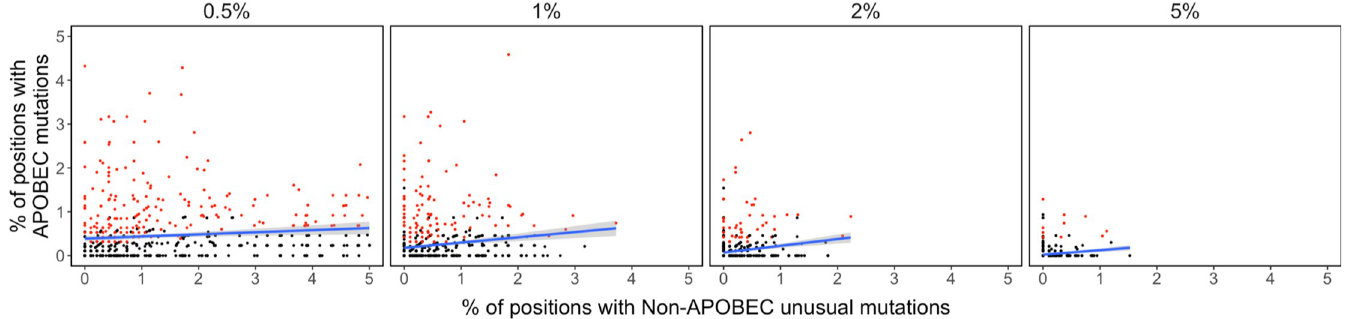
Fig 6. Scatterplots demonstrating the relationship between the number of signature APOBEC mutations and the number of unusual mutations that were not signature APOBEC mutations at four NGS mutation detection thresholds. Samples containing three or more signature APOBEC mutations are shown in red.